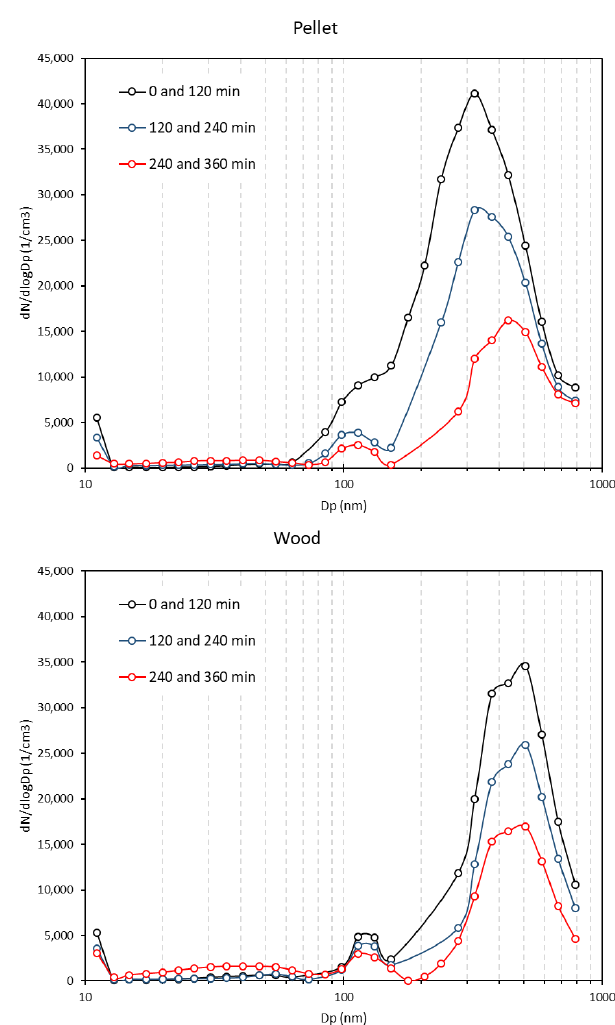
Figure 7. Particle number size distribution over irradiation time for the pellet and wood experiments.